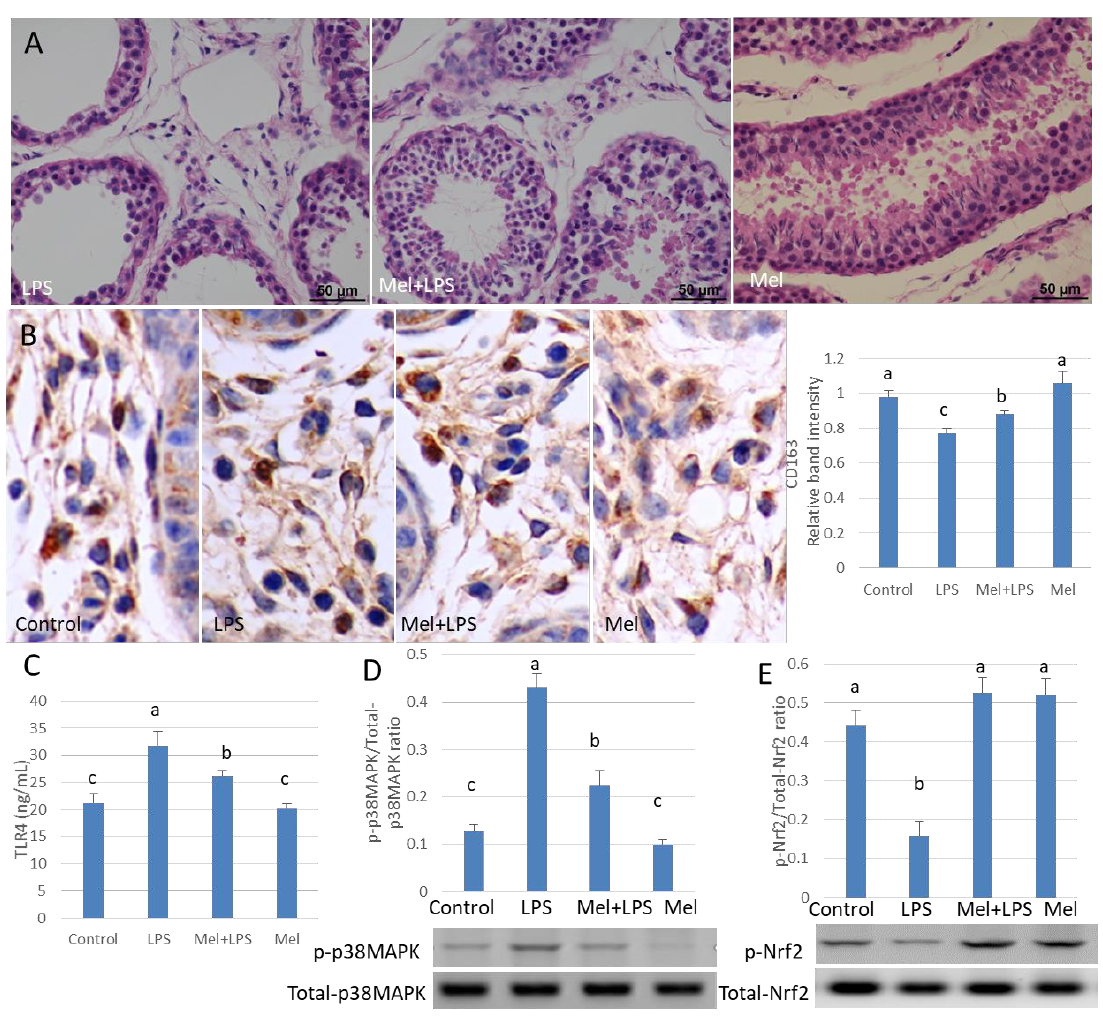
Figure 7. Melatonin alleviates LPS-induced sheep orchitis. ( A ) Testis histopathological HE stains. ( B ) Expression of immunohistochemical CD163 in testicular tissue. ( C ) ELISA detects TLR4 protein expression. Protein expression of ( D ) p-p38MAPK / p38MAPK and ( E ) p-Nrf2 / Nrf2 was detected by Western blotting. All the above experiments were divided into a control group (testicular local injection of saline), LPS injection group, LPS + Mel injection testis group and Mel injection testis group. Data are shown as mean ± SEM. Di ff erent superscript letters (a–c) in each column representative statistically significant di ff erences ( p < 0.05).